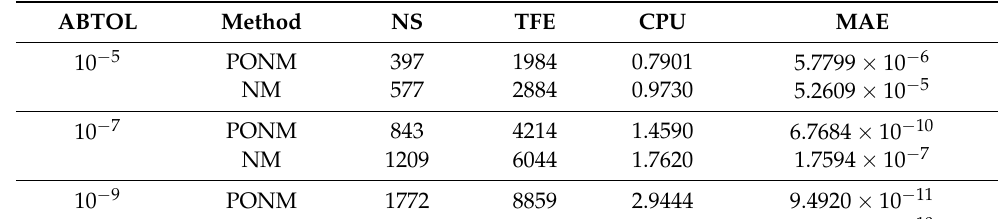
Table 4. Numerical results for (6) with h 0 = 10 − 3 , x ∈ [ 0,60 π ] .